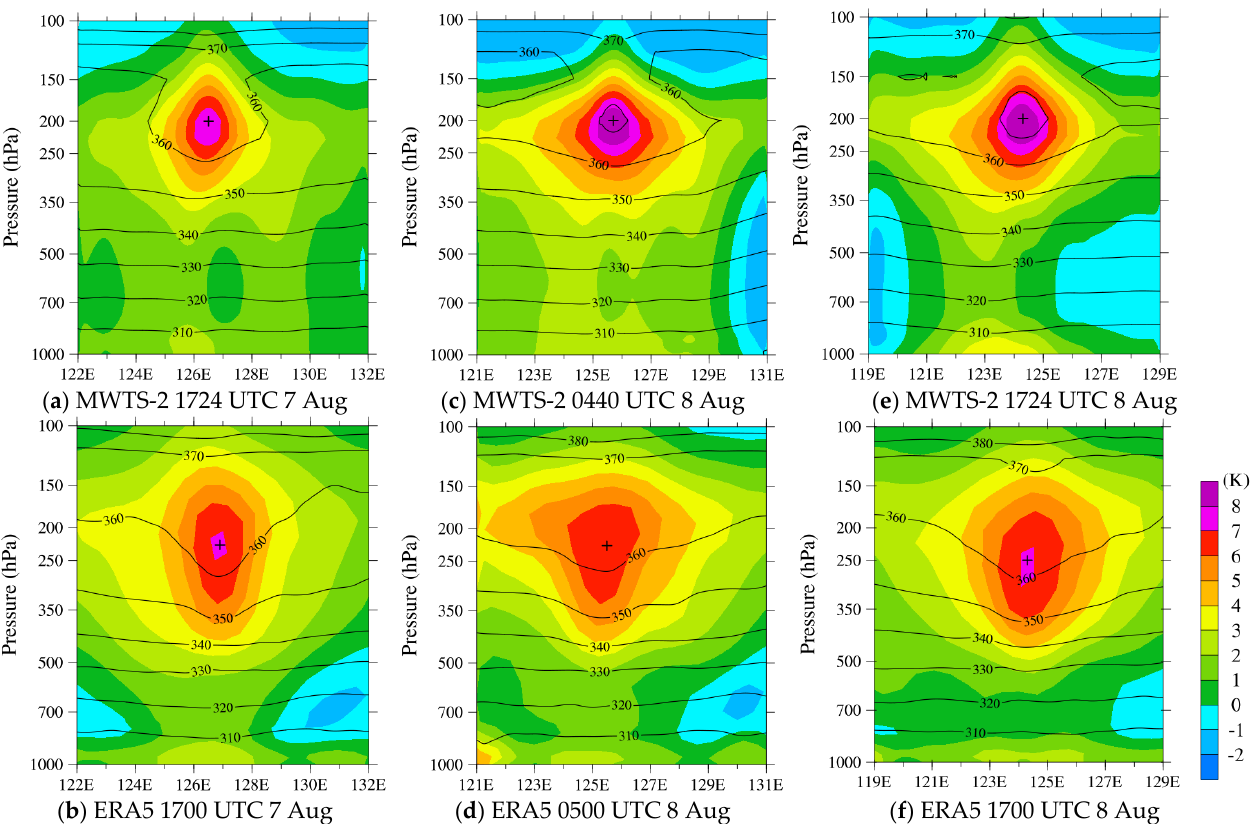
Figure 11. West-east cross-sections of temperature anomalies (shaded) and potential temperatures (contour) from FY-3D MWTS-2 (left panels) and ERA5 (right panels) passing the best track centers of Typhoon Lekima at the same times as Figure 9a,d,g. The black cross stands for the maximum values of the warm-core anomalies.